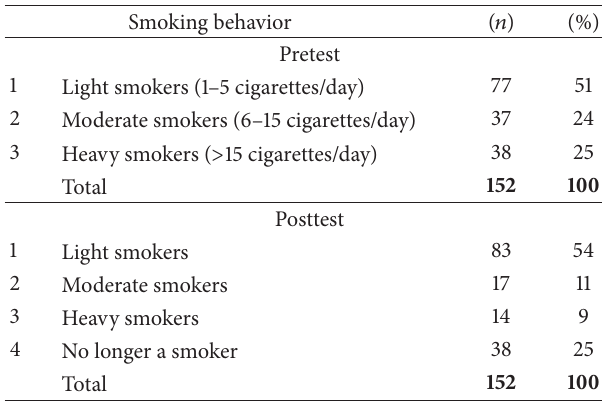
Table 2: Description of smoking behavior of smoking medical